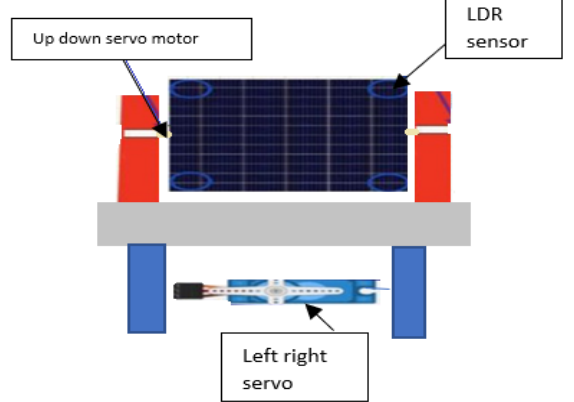
Figure 1. Schematic view of solar tracking system.